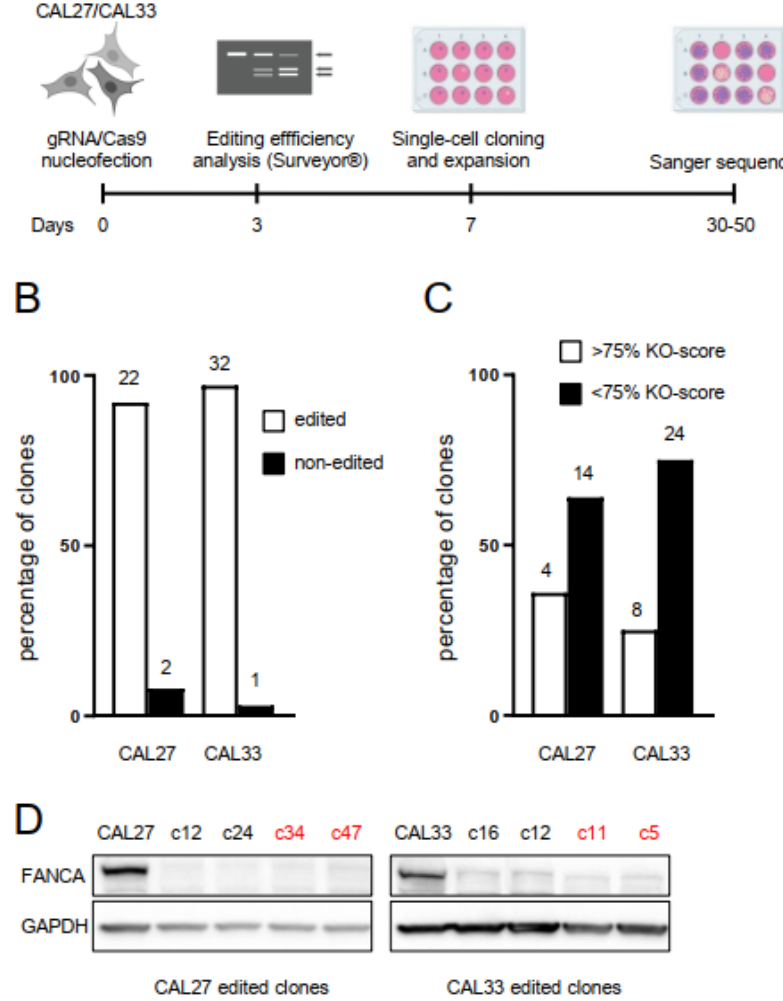
Figure 1. Biallelic mutation in FANCA gene by CRISPR/Cas9 editing in non-FA HNSCC cell lines. ( A ) Schematic model of FANCA -mutant clones generation. CAL27 and CAL33 cells were nucleofected with a ribonucleoprotein mix of a FANCA gene CRISPR guide RNA (gRNA) and purified Cas9 protein. Editing efficiency was evaluated three days after by nuclease assay using the Surveyor ® Mutation Detection Kit (IDT). Single cells were plated using fluorescence-activated cell sorting (FACS) and expanded in conditioned medium. Sanger sequencing was performed on randomly selected, single-cell clones to assess for inactivating mutations in both alleles. ( B ) The vast majority of sequenced clones displayed FANCA -gene editing, both from CAL27 and CAL33 cells. Numbers of edited or non-edited clones are shown above each bar. ( C ) Knock-out score (KO-score) was estimated for each clone upon Sanger sequencing using the ICE algorithm [16]. Between 24% and 36% of edited clones displayed high KO scores (>75%). ( D ) Clones having highest KO scores display negligible levels of FANCA protein, validating the editing approach. Clones highlighted in red were selected for further